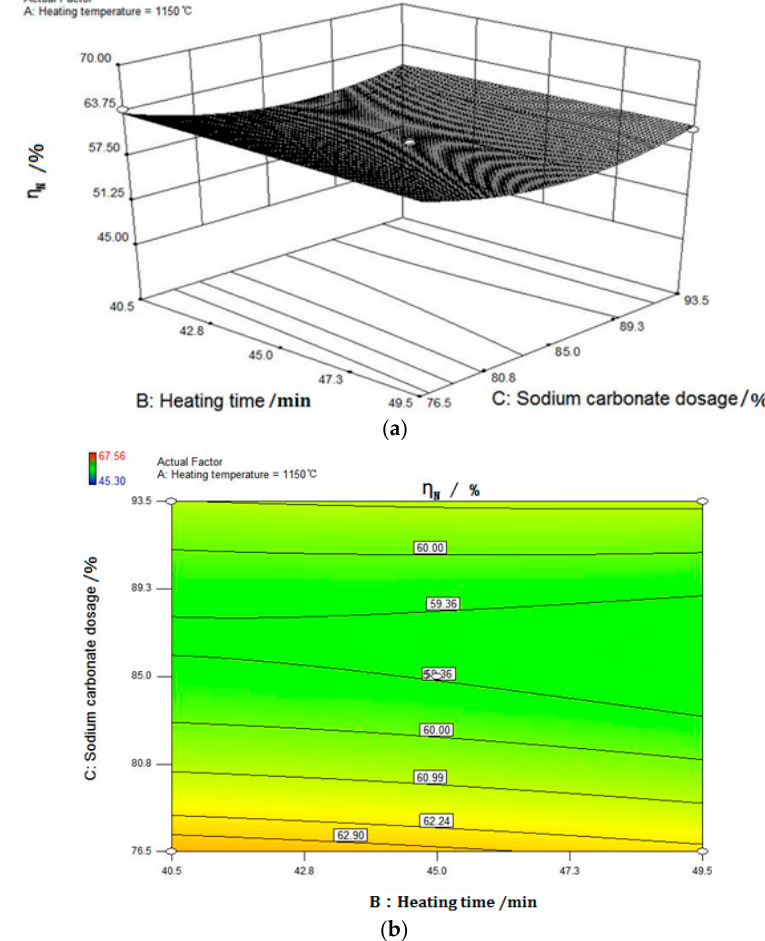
Figure 5. ( a ) Response surface of heating time–sodium carbonate dosage; ( b ) contour of heating time–sodium carbonate dosage plot.